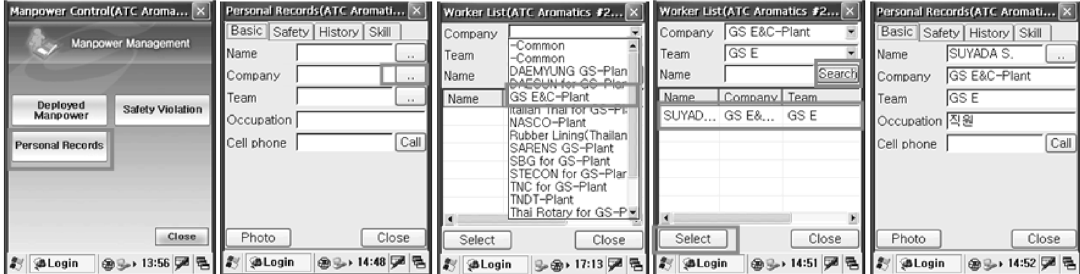
Fig. 10. Personal records on PDA